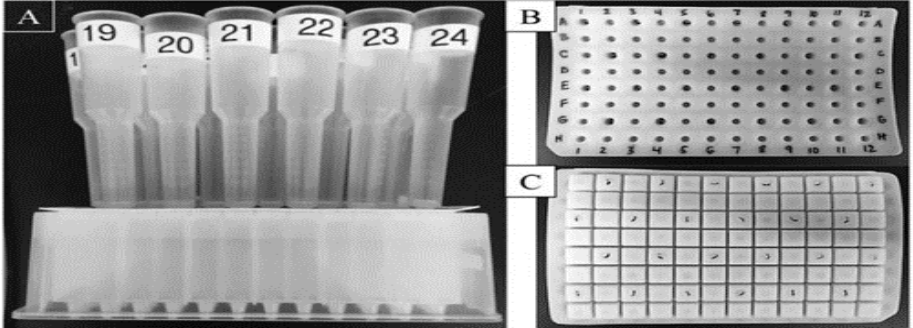
Figure 2. ( A ) The MCPA system has 24 columns ( B ) Even though got 96 columns but ( C ) six evenly spaced holes per row over alternating lines for parallel protein purification [9].